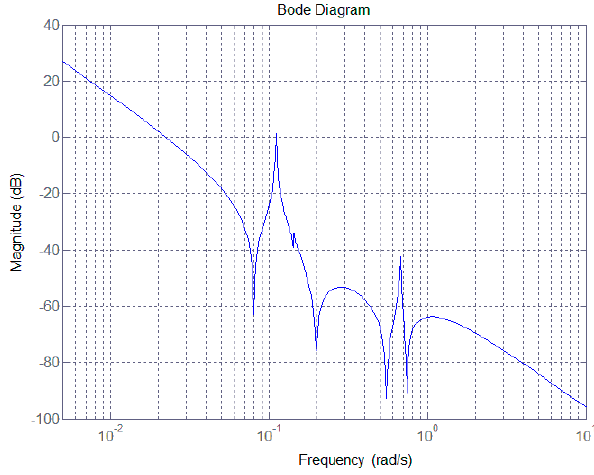
Figure 3. Bode magnitude diagram subject to modal parameter uncertainty.